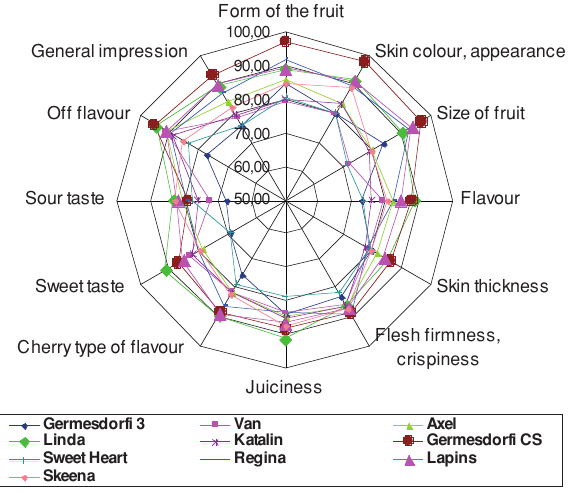
Figure 11. Profile diagram of the evaluation of late ripening sweet cherry varieties according to sensorial judgement